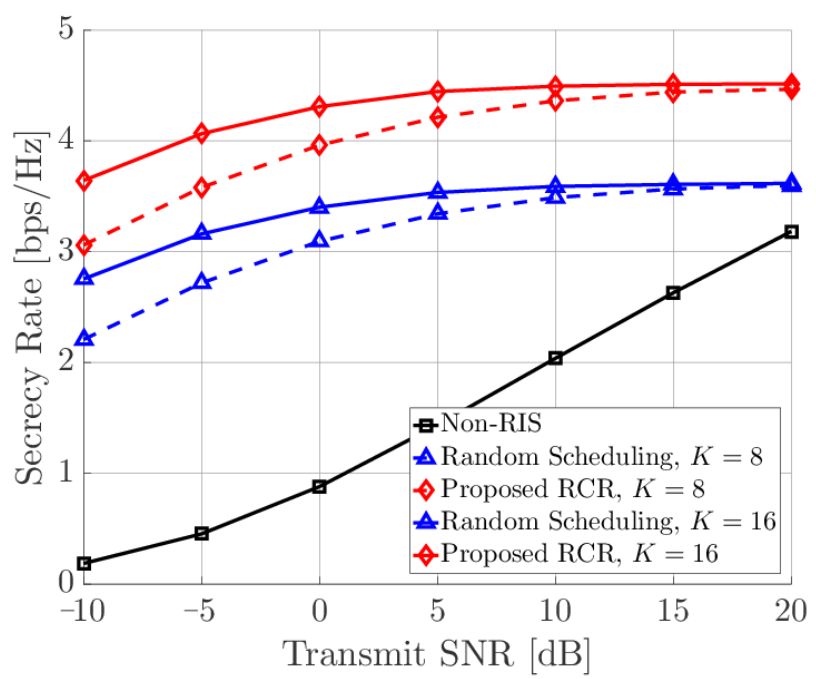
Figure 3. Secrecy rate performance according to transmitted